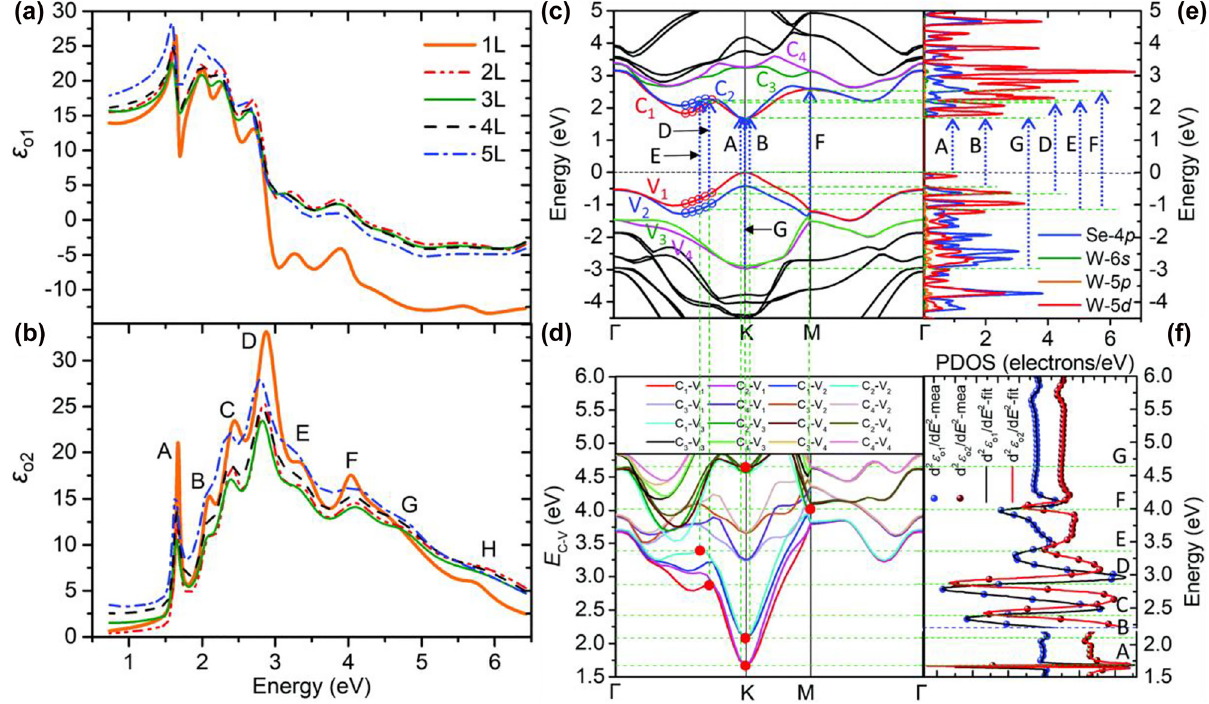
Figure 2: Optical permittivity and electronic band structure. (a) Real parts ( ε o1 ) and (b) imaginary parts ( ε o2 ) of the in-plane permittivity of 1 – 5L WSe 2 . (c) Corresponding electronic band structure, (d) energy differences E C – V between the fi rst four conduction and valence bands, (e) projected density of states (PDOS), and (f) critical